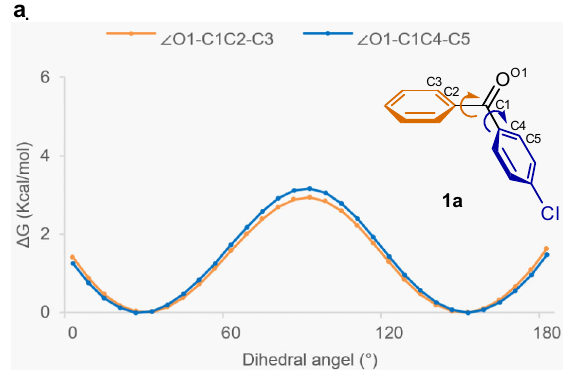
Fig. 7 | Energy diagram of a relaxed scan of the dihedral angle between the carbonyl group and the aromatic ring in 1a and 1a-Cr. The relative Gibbs free energies are given in kcal/mol. a Energy diagram of a relaxed scan of the dihedral